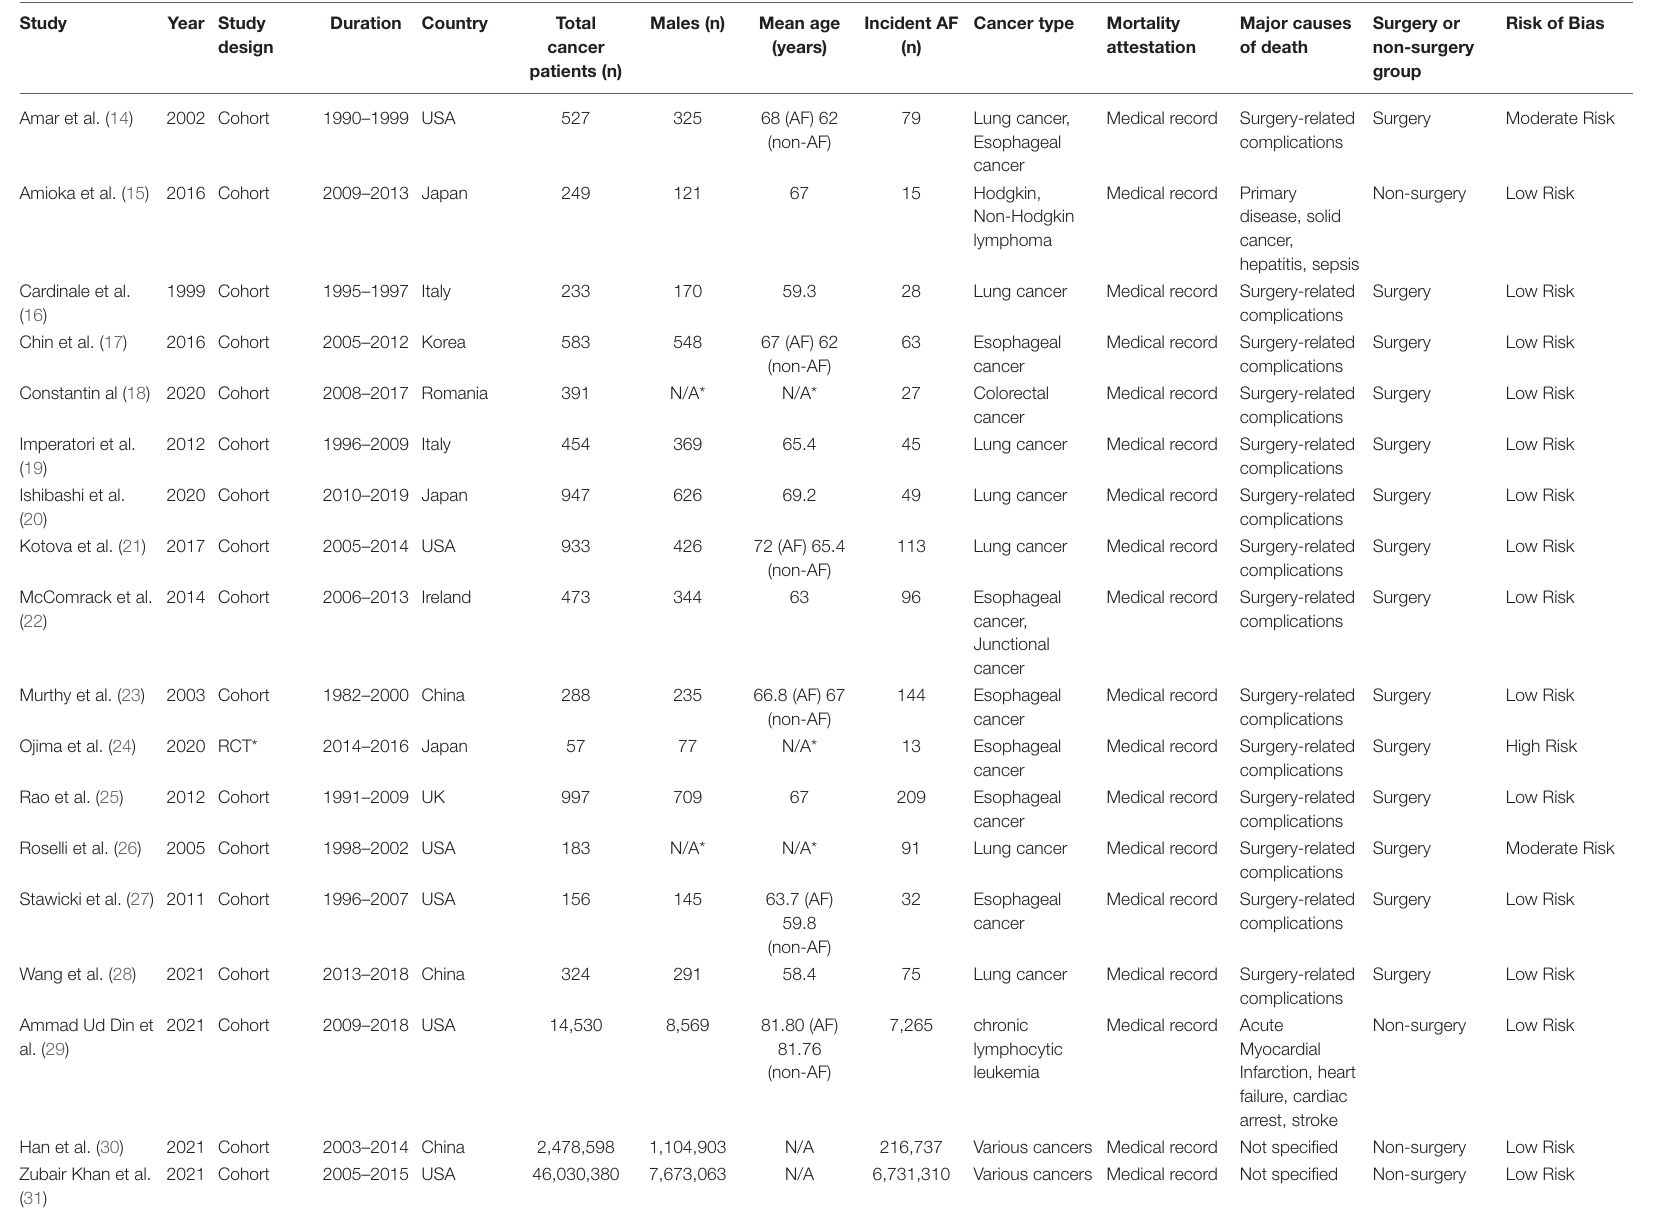
TABLE 4 | Characteristics of included